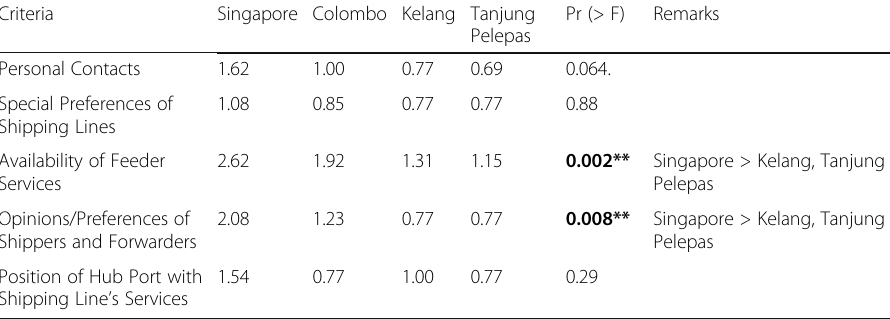
Table 12 Average Appreciation Scores (AvAS) of Hub Ports (Continued)